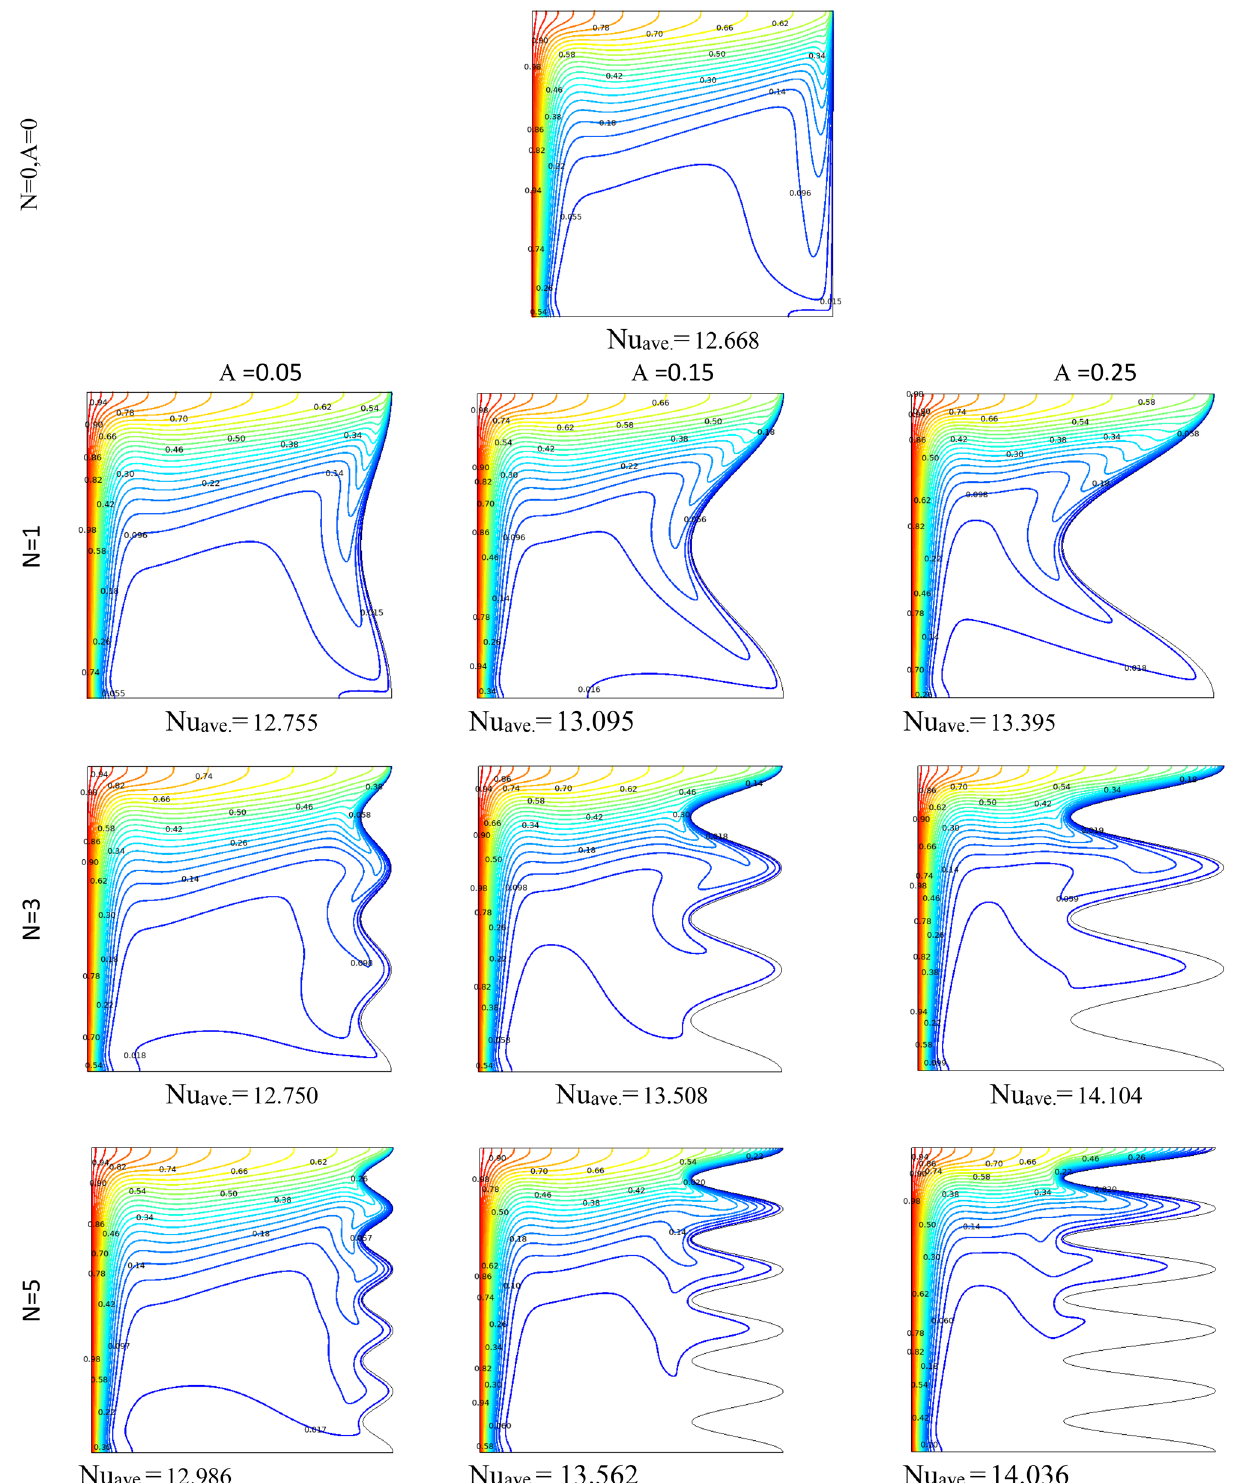
Figure 5. Streamlines and isotherms at (Da = 1e−3, Re = 200, λ = 5, φ = 0.03, Ha = 25, γ = 45, Ri = 10) for Case